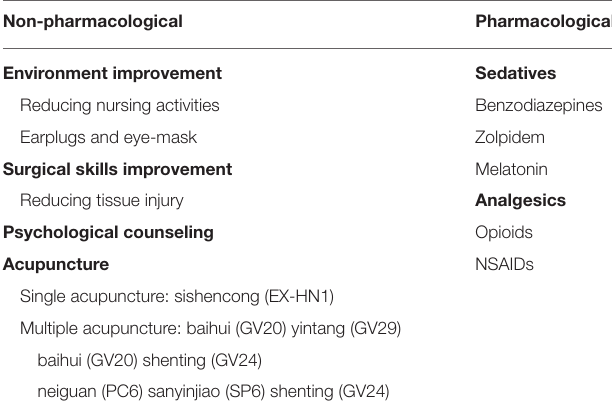
TABLE 1 | Treatment of postoperative sleep